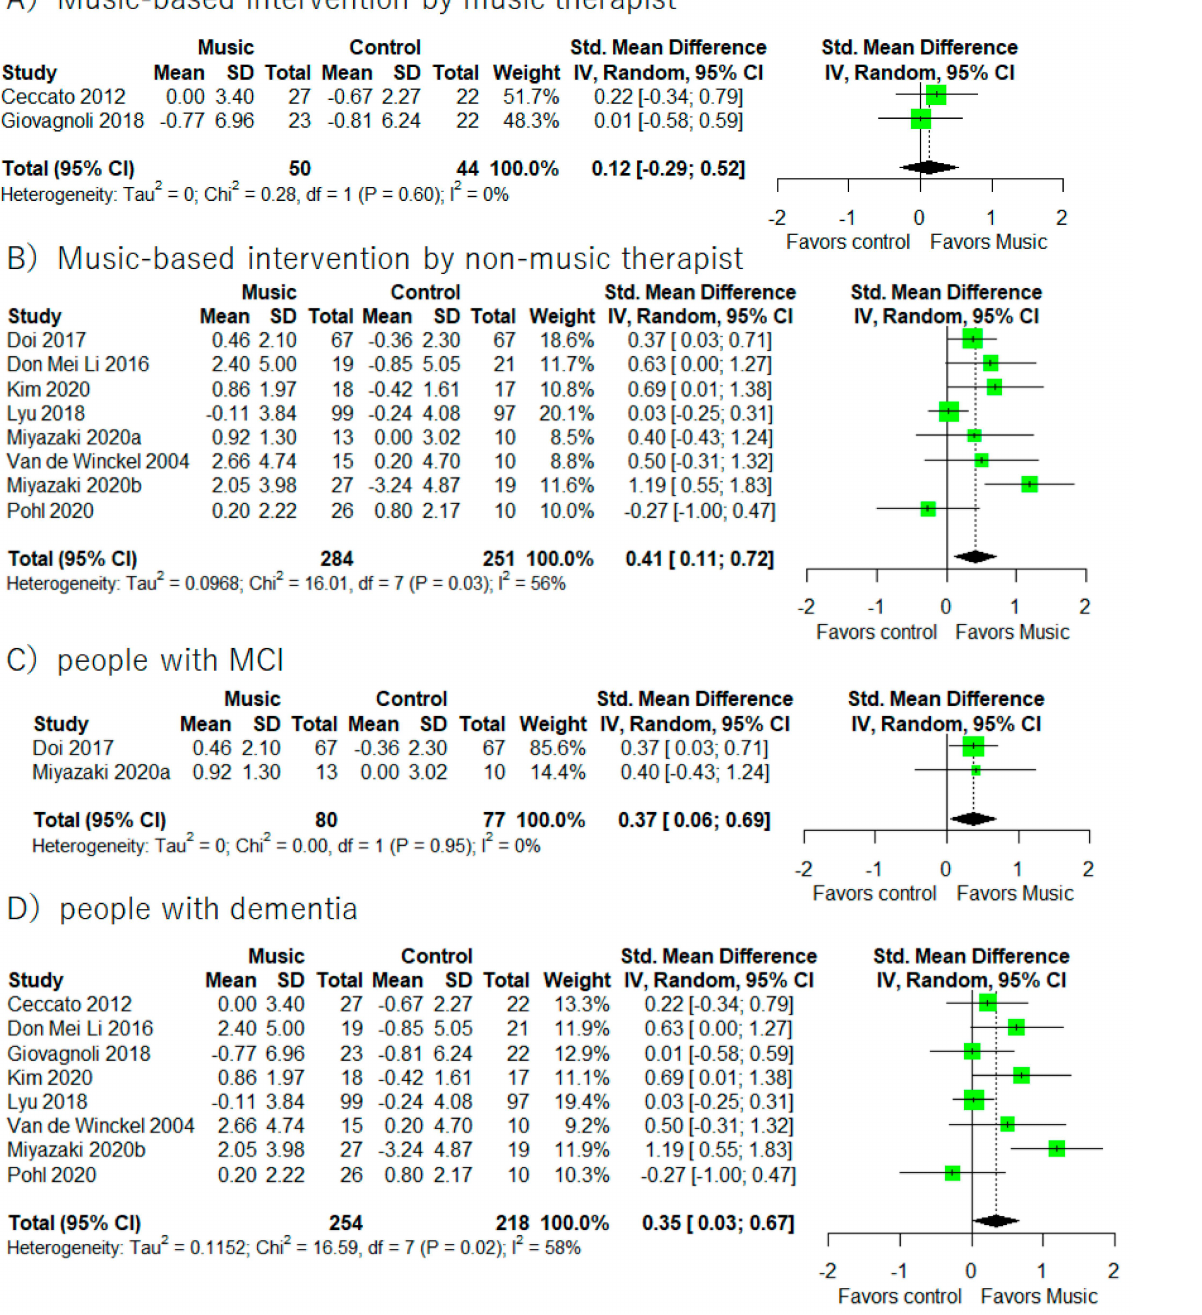
Figure 3. Trial level data, effect estimates, and forest plot in supplementary meta-analyses for music- based intervention by music therapist ( A ), music-based intervention by non-music therapist ( B ), people with MCI ( C ), and people with dementia ( D ). The area of green square is proportional to the study’s weight in the